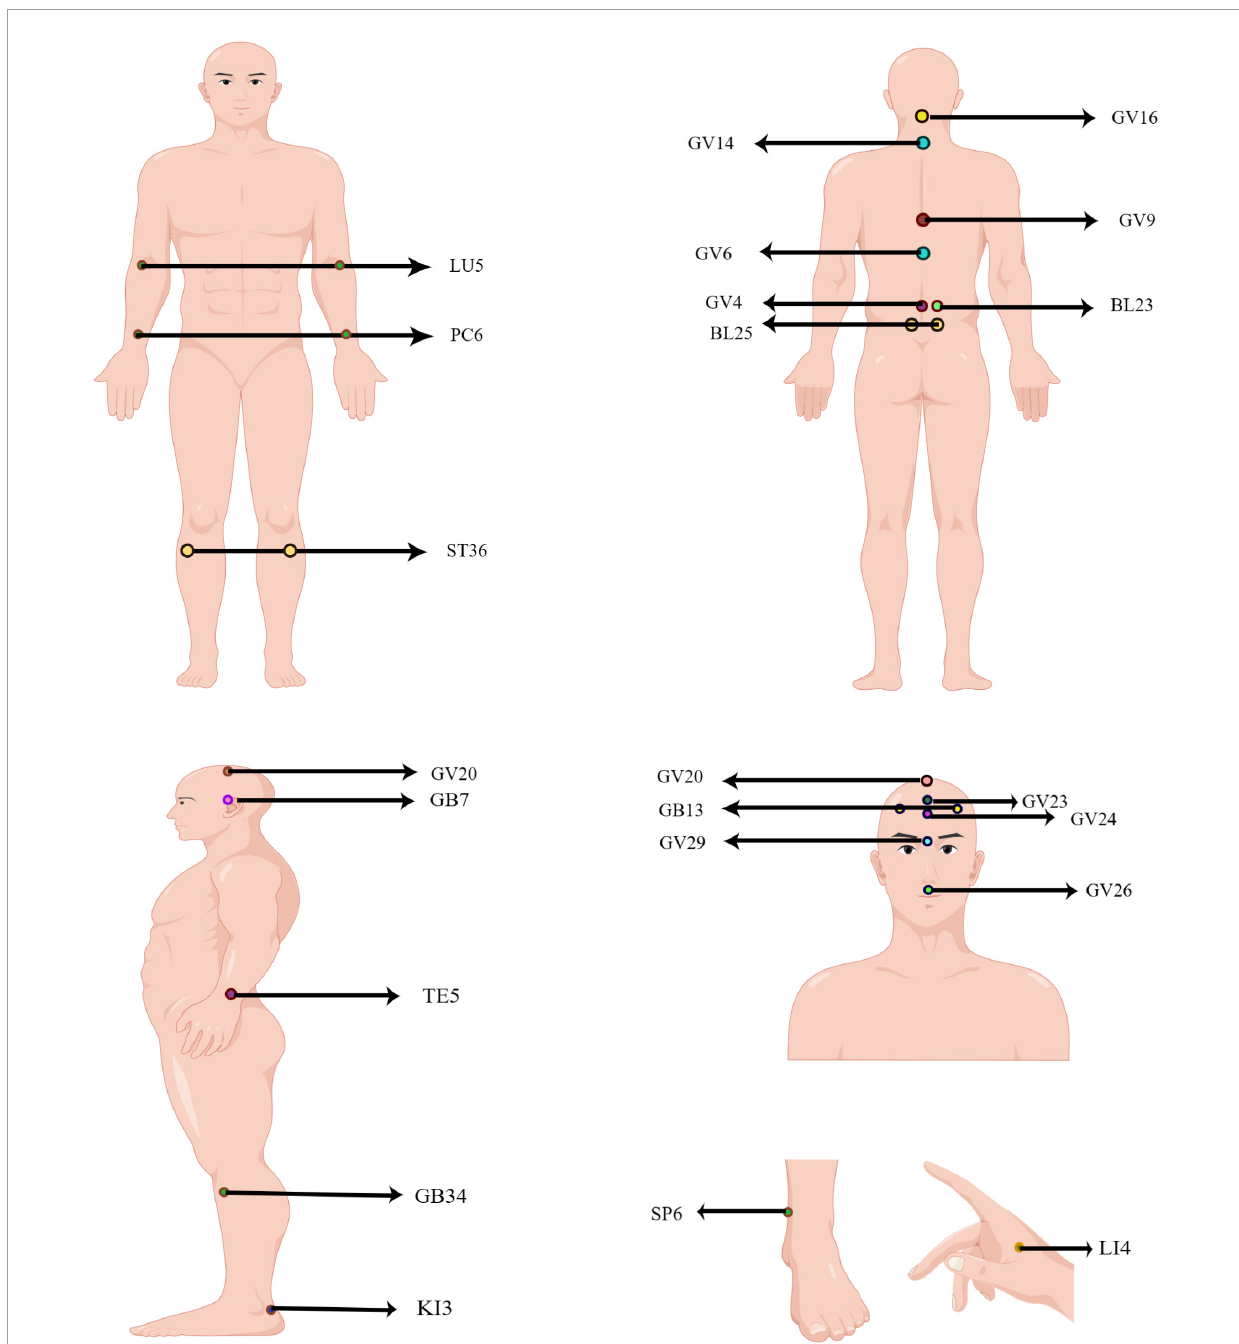
FIGURE1 Human acupoints frequently used in CNS diseases. The locations of acupoint code are marked in the figure. GV20: Baihui; GV14: Dazhui; GV26: Shuigou; GV29: Yintang; GV24: Shenting; GB13: Benshen; GB7: Qubin; GV23: Shangxing; GV16: Fengfu; GV9: Zhiyang; GV6: Jizhong; GV4: Mingmen; ST36: Zusanli; GB34: Yanglingquan; BL23: Shenshu; LU5: Chize; LI4: Hegu; SP6: Sanyinjiao; TE5: Waiguan; PC6: Neiguan; BL25: Dachangshu; KI3: